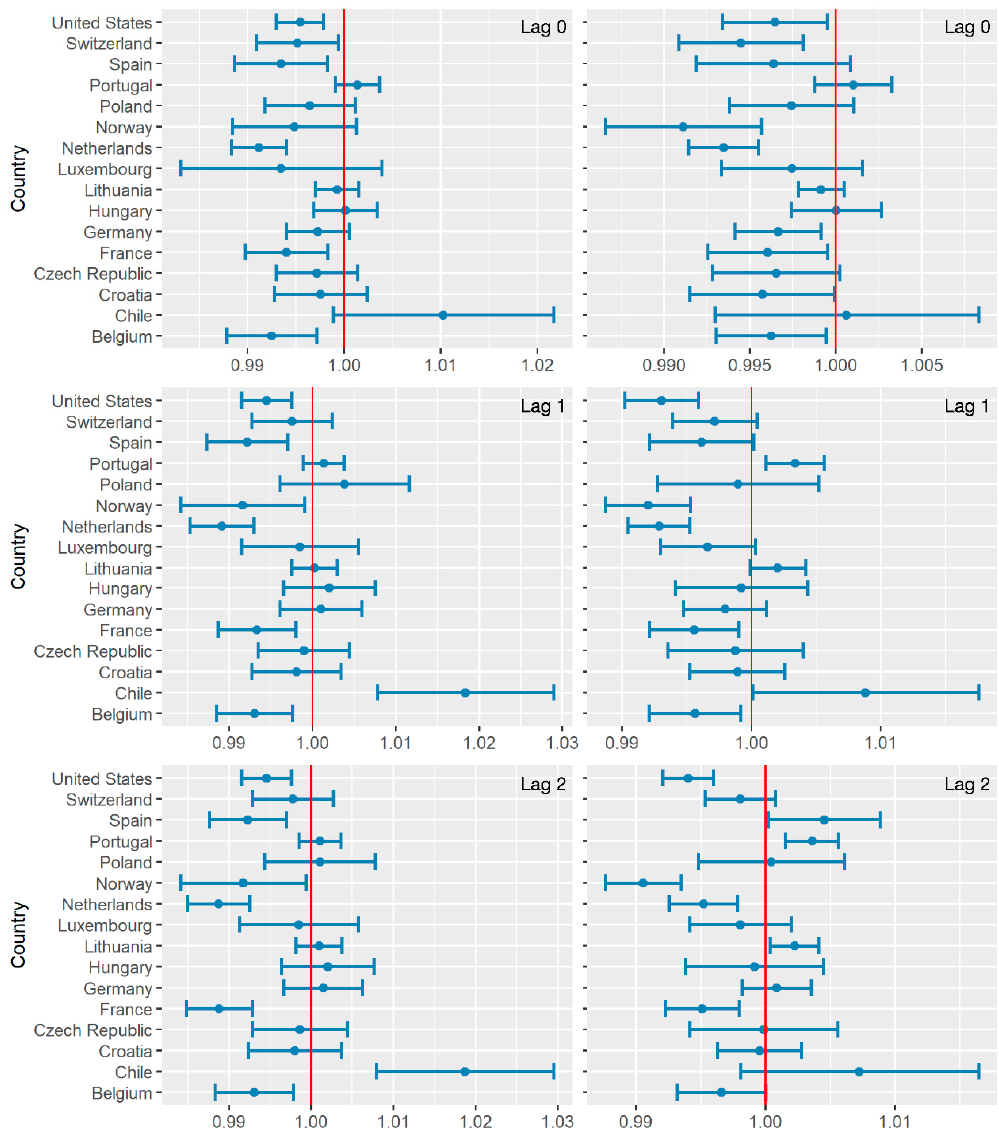
Figure 8. The relative risks of workplace visitation frequency, related to excess mortality and COVID-19 mortality, with lag effects of 0,1, and 2 weeks.